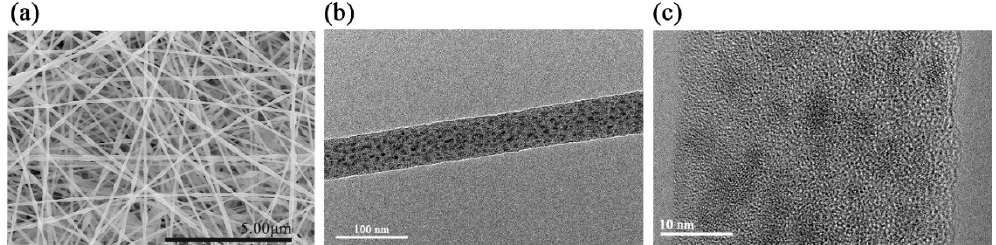
Figure 1. ( a ) Scanning electron microscopy (SEM) image of polyvinylidene fluoride (PVDF)-MAPbBr 1.2 Cl 1.8 nanofibers. ( b ) Transmission electron microscope (TEM) image of a single PVDF